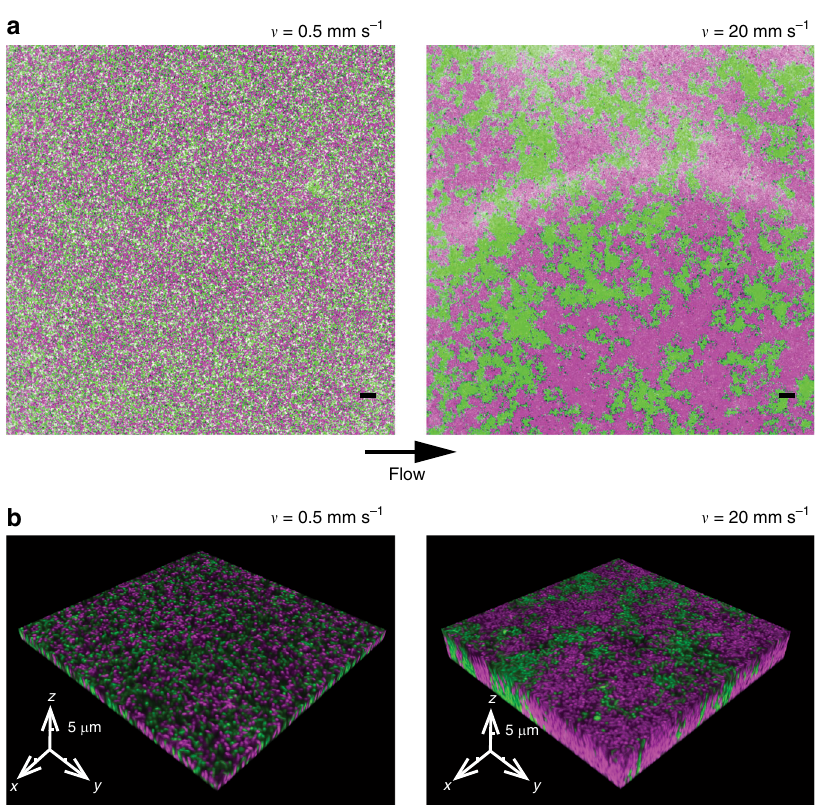
Fig. 5 Flow-dependent colonization patterns persist on longer time scales and in three dimensions. Bio fi lms of C. crescentus expressing either mKate or Venus fl uorescent proteins, grown under low (0.5 mm s − 1 ) or high (20 mm s − 1 ) fl ow during 6 days. a At the channel surface, bio fi lm mixing patterns after 6 days recapitulate those obtained after 24 h (Fig. 3a). Scale bar: 10 μ m. b 3D rendering of a z-stack acquisition of bio fi lms grown for 6 days under fl ow. Characteristic mixing patterns previously observed on the surface of channel also extend in the third dimension. Green: C. crescentus mKate. Magenta: C. crescentus